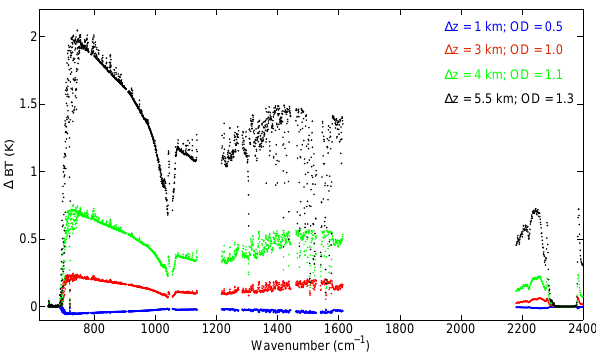
Fig. 9. Mean BSPs for cirrus clouds with selected midlayer temperature intervals. Tropical regions at daytime are considered.